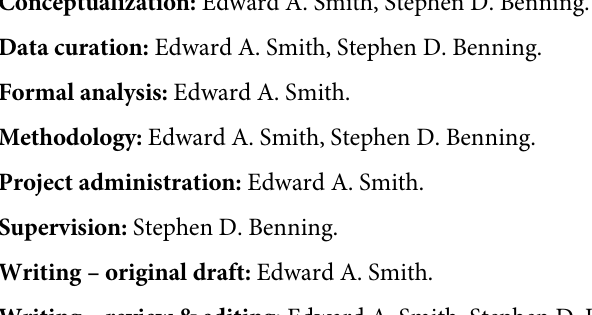
S3 Fig. Two-way interaction between Reward Magnitude and Reward Probability on APRT Go Presses